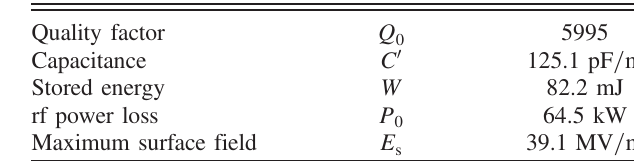
TABLE II. Computed rf quantities for V 0 ¼ 35